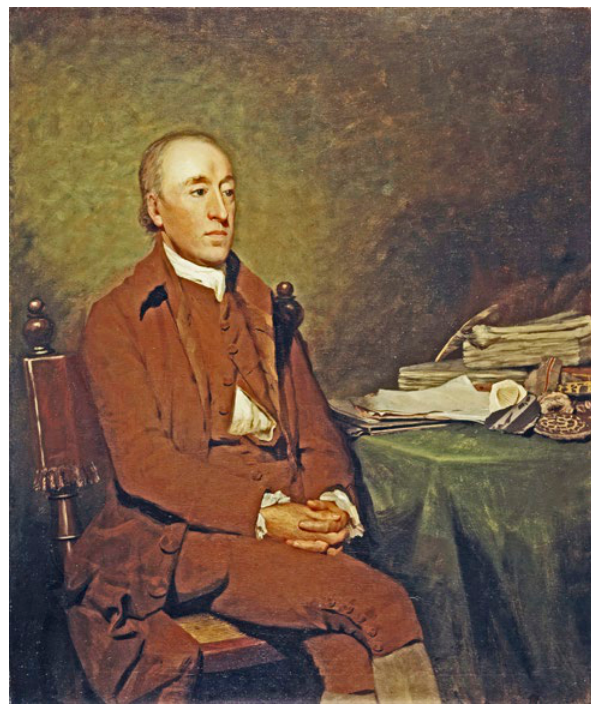
Figure 25. James Hutton 1726 to 1797 (from Wikipedia).